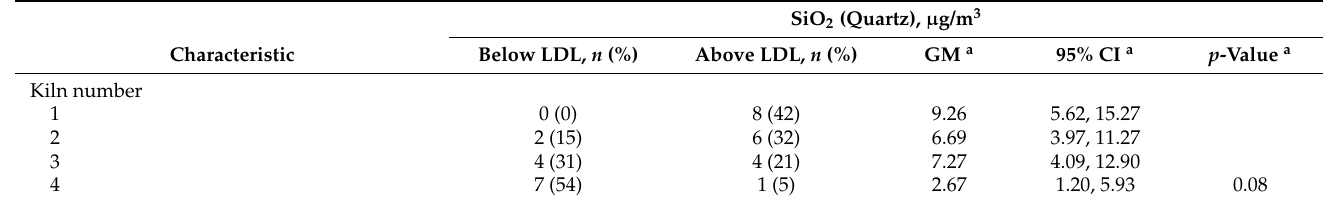
Table 4. Associations between characteristics and SiO 2 (quartz) air concentrations measured